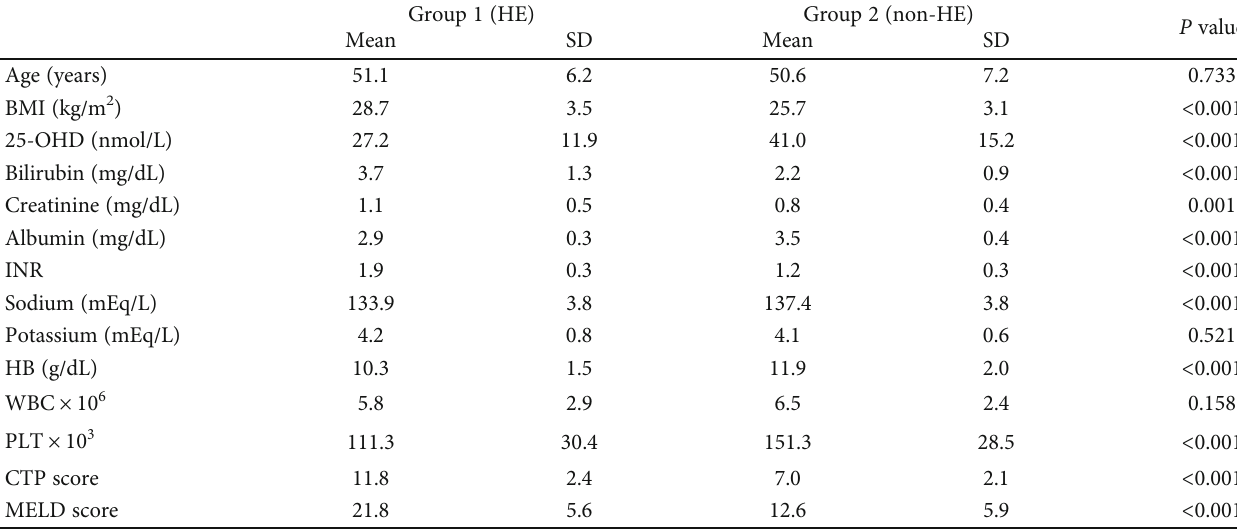
Summaryof the results ofthe descriptive study ofdemographic, laboratory, and clinical variables included in the CTP and MELD scores. BMI:body mass index; 25-OHD: 25-hydroxy vitamin D; INR: international normalized ratio; HB: hemoglobin; WBC: white blood cell count; PLT: platelet count; CTP: Child Turcotte Pugh; MELD: model for end Stage liver disease. The independent t -test was